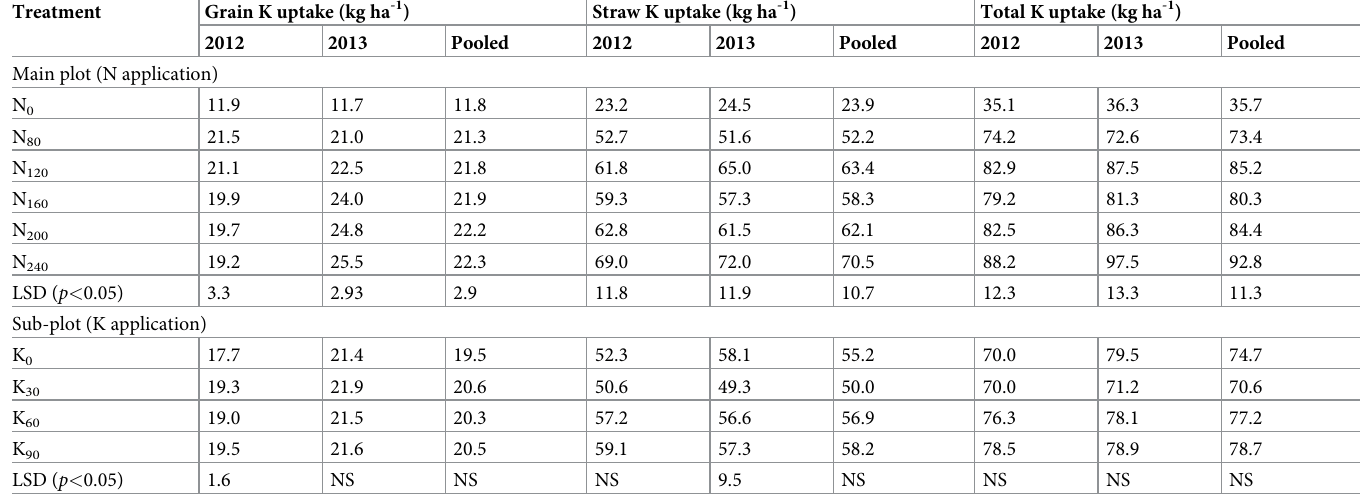
Table 4. Effect of nitrogen (N) and potassium (K) application on K uptake by grain and straw of wheat ( Triticum aestivum L.) in a sandy loam soil in sub-tropical India. Treatment Grain K uptake (kg ha -1